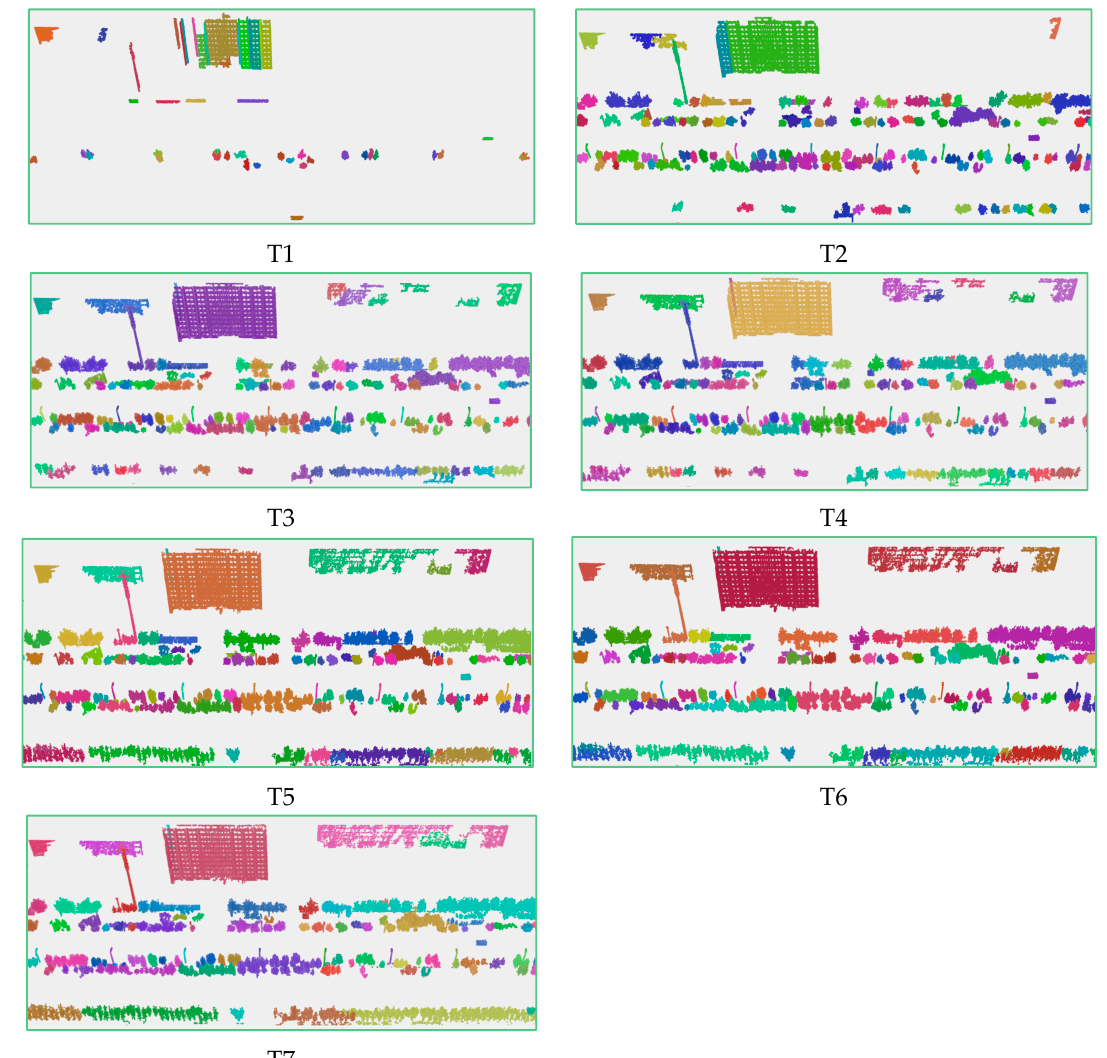
Figure 16. Part segmentation results of the mobile laser scanning data using X, Y, Z fields.